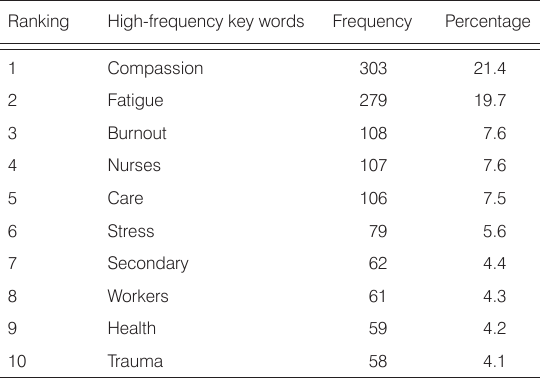
Table 4. High-frequency key words in the study ( n =